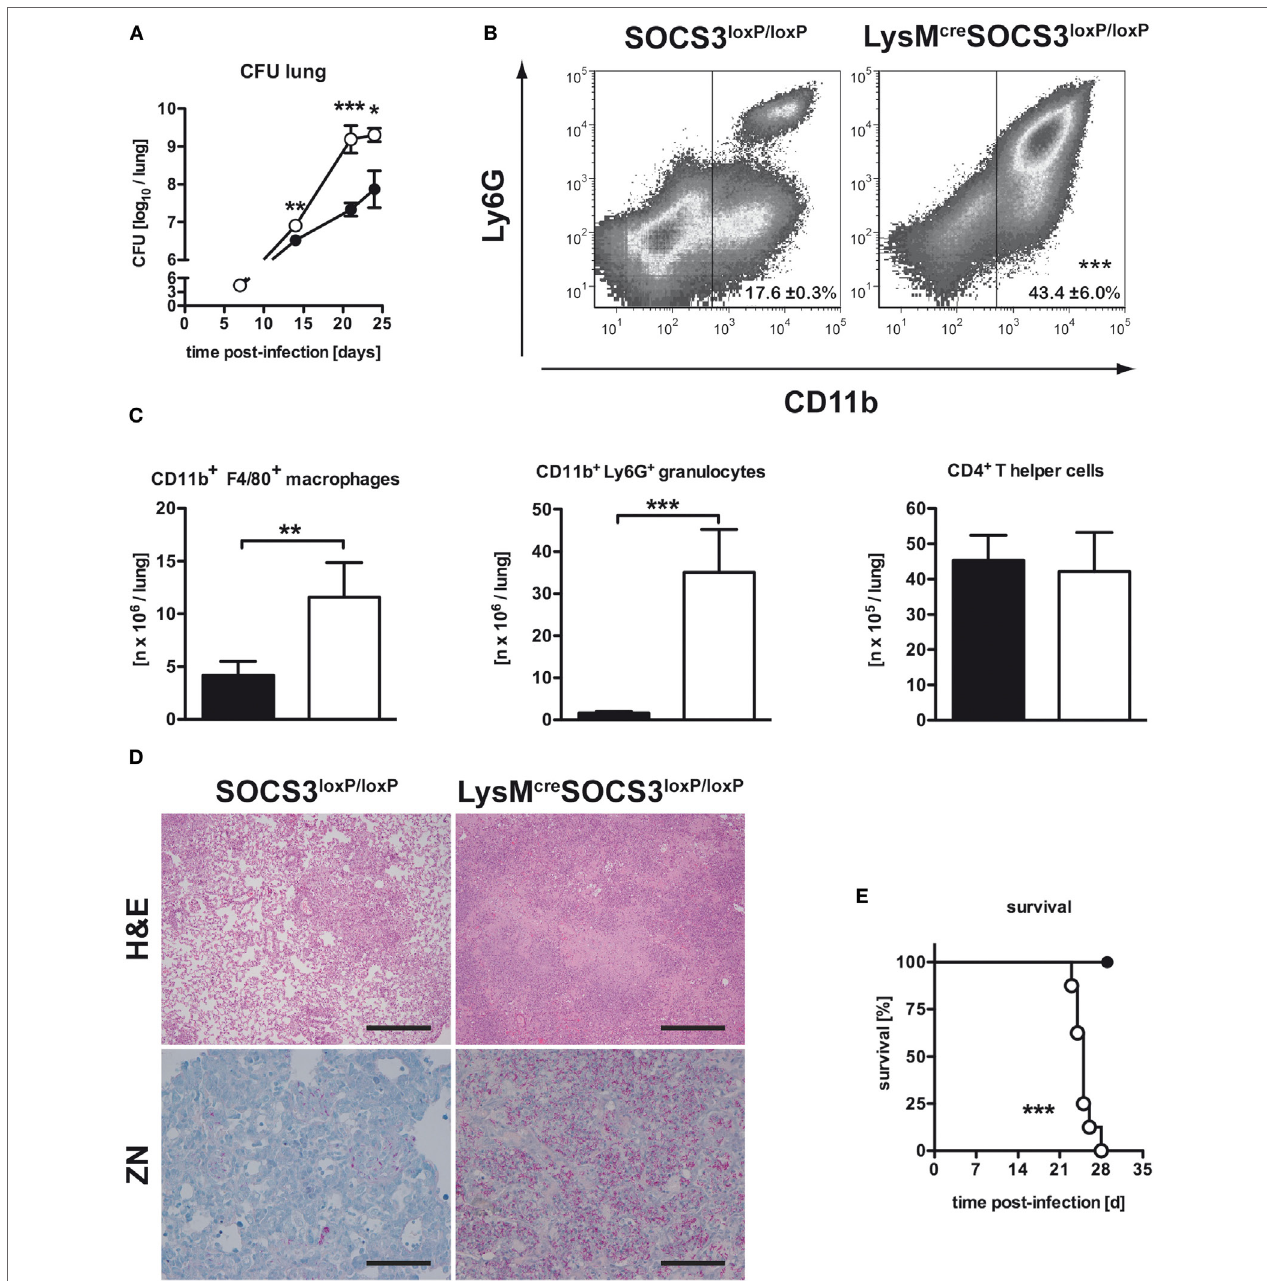
FigUre 1 | Macrophage-specific suppressor of cytokine signaling 3 (SOCS3)-deficient mice were highly susceptible to Mtb infection. Cre-negative SOCS3 loxP/loxP control mice (black symbols) and LysM cre SOCS3 loxP/loxP mice (white symbols) were infected with approximately 1,000 CFU Mtb via the aerosol route and lungs were isolated at the indicated time points. (a) For mycobacterial colony enumeration assays, aseptically removed lungs were weighed, transferred into PBS containing a proteinase inhibitor cocktail and homogenized. Tenfold serial dilutions of organ homogenates were plated and colonies were counted 3 weeks later. One experiment representative of three performed is shown. (B,c) At 23 days of infection, perfused lungs were digested and single-cell suspensions were analyzed by flow cytometry for surface expression of CD11b and Ly6G (B) . (c) After automated cell counting and flow cytometry of CD11b + F4/80 + macrophages, CD11b + Ly6G + granulocytes, and CD4 + T cells, absolute numbers of these cell populations were calculated. Data represent means ± SD of at least five mice per group. One experiment representative of two performed is shown. Statistical analysis was performed as described in experimental procedures defining differences between SOCS3 loxP/loxP and LysM cre SOCS3 loxP/loxP mice as significant (*** p < 0.001; ** p < 0.01). (D) Hematoxylin/eosin (H&E, original magnification 100 × ; scale bar = 1 mm) and Ziehl–Neelsen staining (ZN, original magnification 400 × ; scale bar = 0.25 mm) of sections from formalin-fixed and paraffin-embedded lungs isolated from mice after 27 days of infection. (e) Survival of 10 infected mice per group was monitored. Animals that lost more than 25% of their original body weight were sacrificed. Statistical analysis was performed as described in experimental procedures defining differences between SOCS3 loxP/loxP and LysM cre SOCS3 loxP/loxP mice as significant (*** p ≤